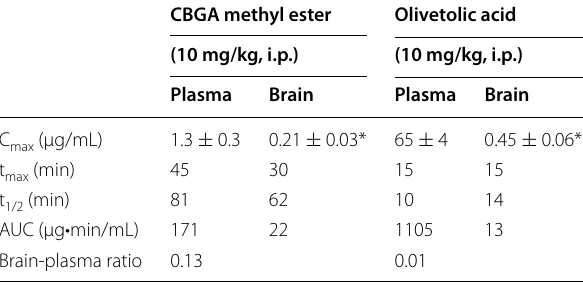
Table 1 Pharmacokinetic parameters in mouse plasma and